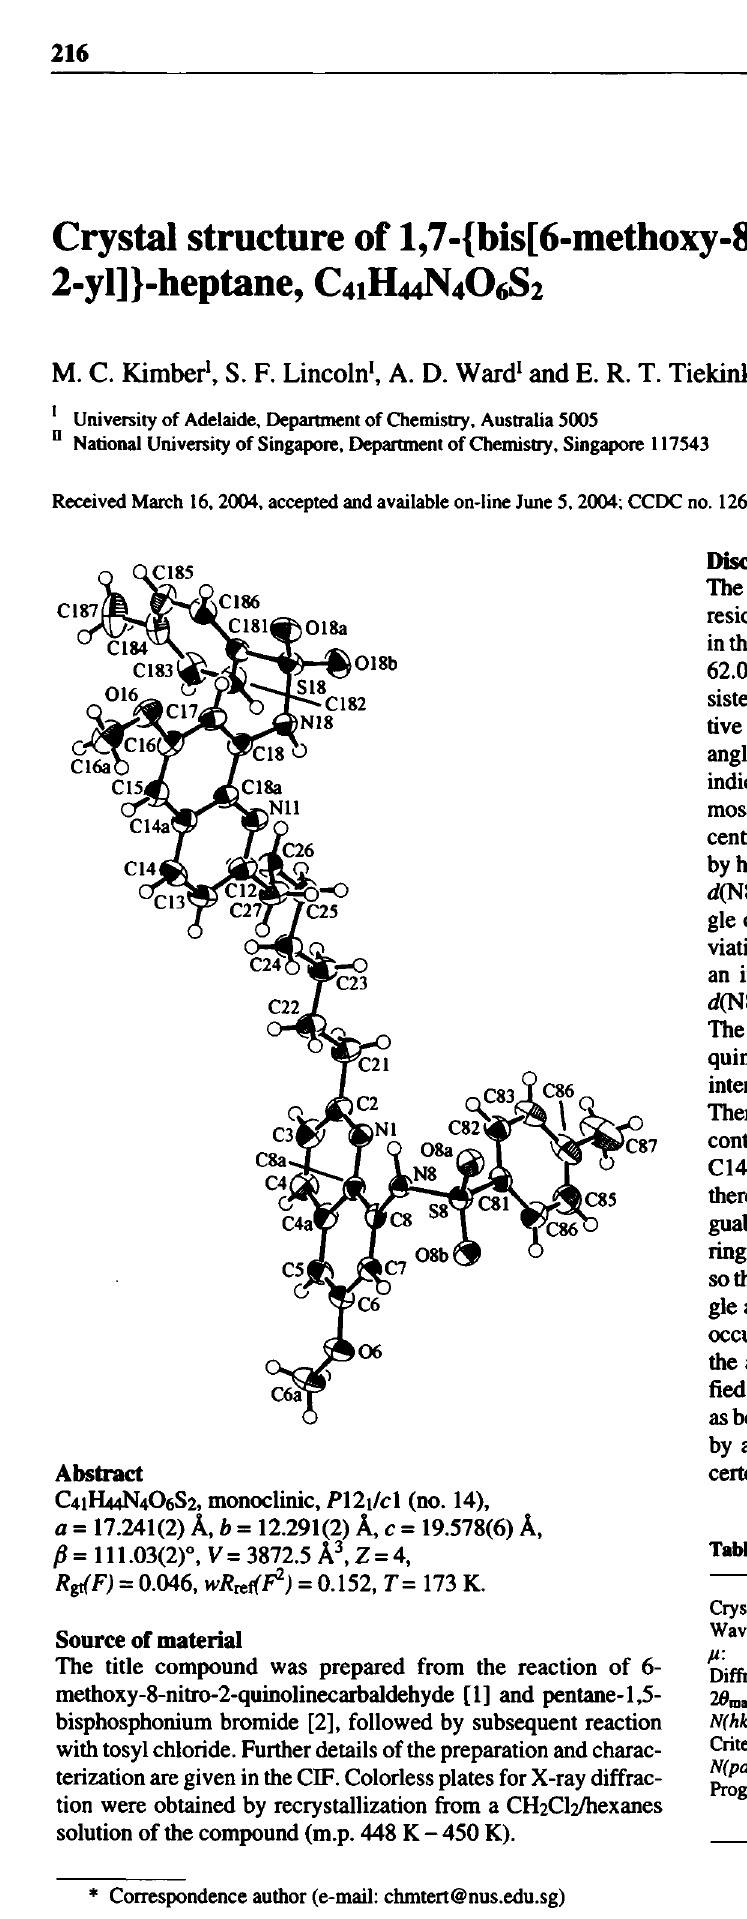
Table 1. Data collection and handling.